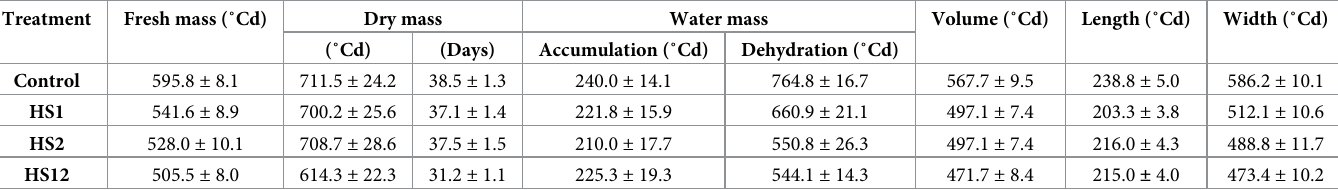
Table 3. Estimated rate of growth of basal grains from the central spikelets of wheat plants exposed to heat shocks. Treatment